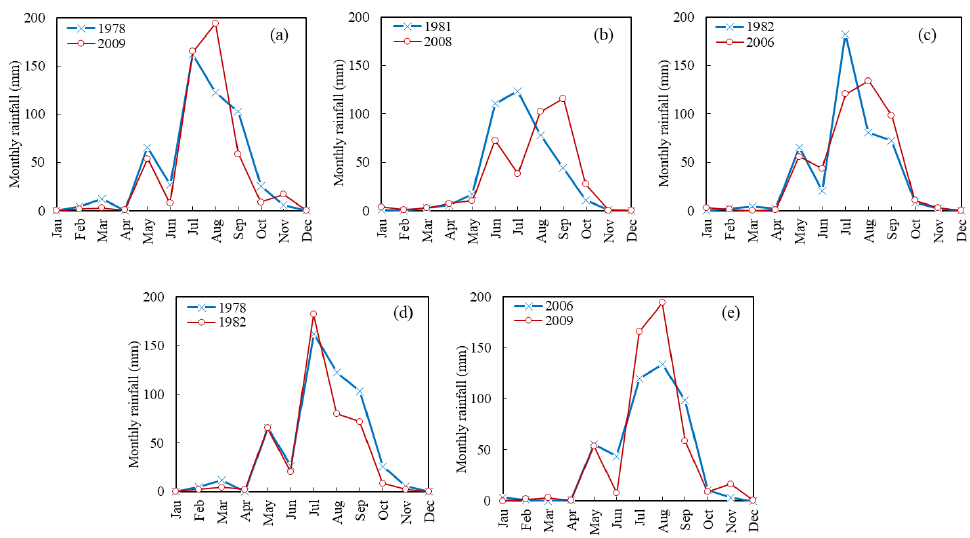
Figure 7. Comparison of the distribution of monthly rainfall during three similar hydrological year groups (( a ) Group 1: 1978 and 2009; ( b ) Group 2: 1981 and 2008; ( c ) Group 3: 1982 and 2006; ( d ) Group 4: 1978 and 1982; ( e ) Group 5: 2006 and 2009).